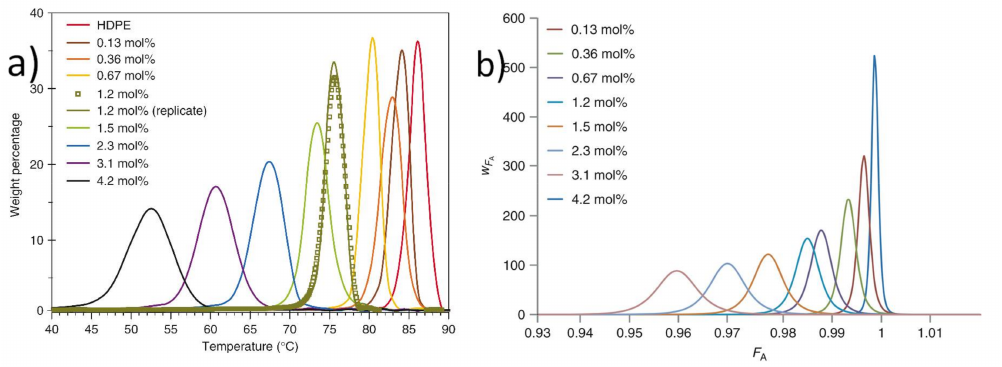
Figure 7. ( a ) CRYSTAF profiles of ethylene/1-hexene copolymers prepared from a single-site